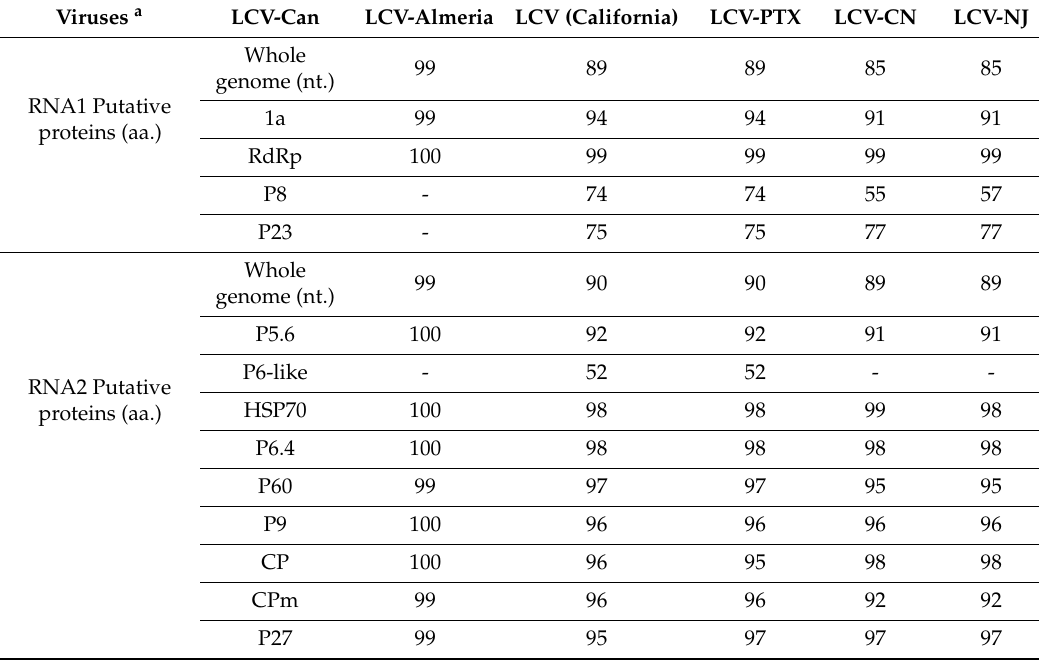
RNA1 Putative proteins (aa.)